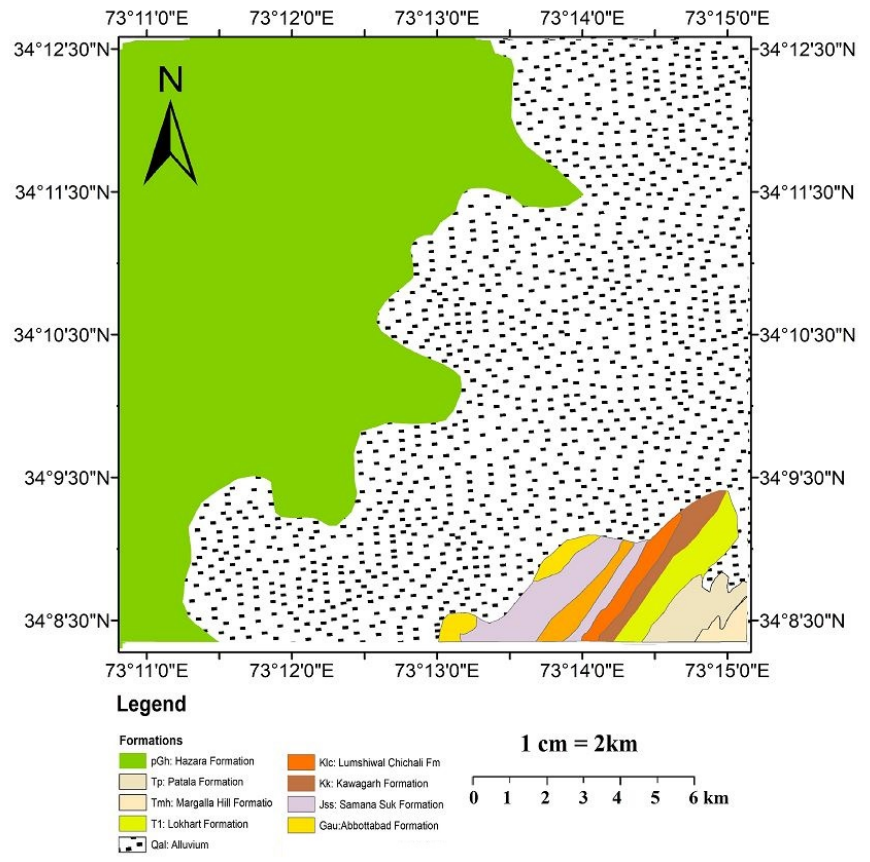
Figure 2. Geological map of the study area.